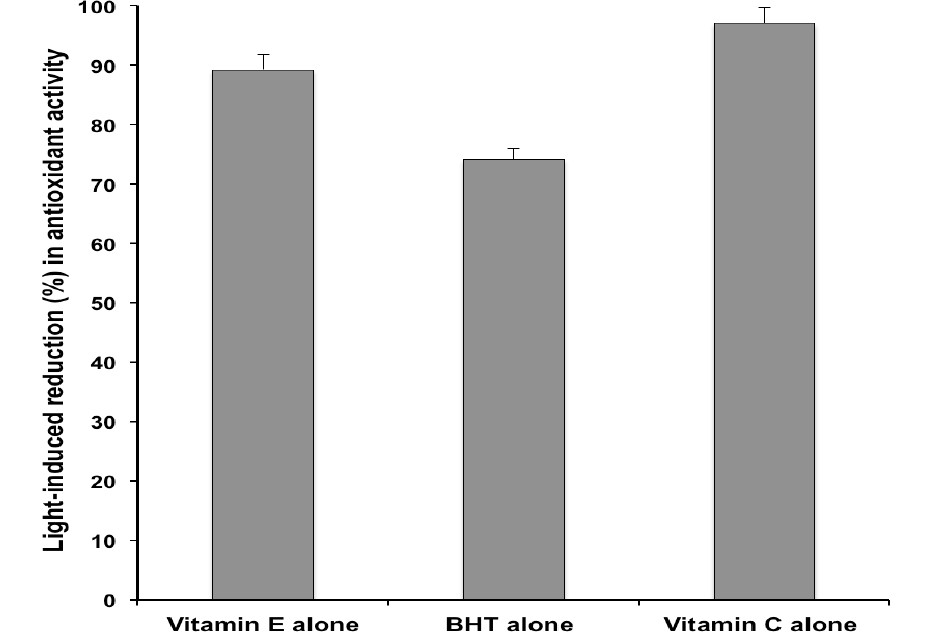
Figure 6. Antioxidant activity reduction (%) of formulations containing vitamin E, BHT or vitamin C as the only antioxidant, after 1 h irradiation with the solar simulator. Each value is the mean ± S.D. of at least six